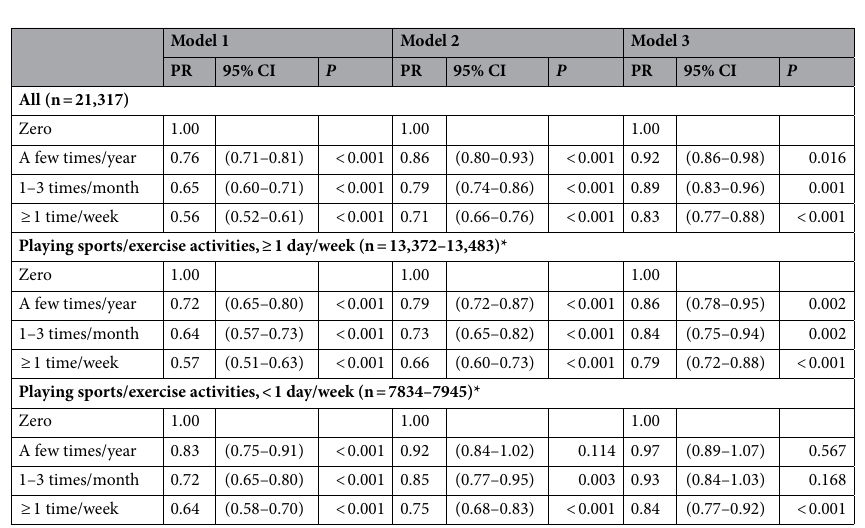
Table 3. Prevalence ratios (PRs) and 95% confidence intervals (CIs) of depressive symptoms according to frequency of watching sports via TV/Internet. * Estimation sample varies across imputations. Depressive symptoms were defined as a 15-item Geriatric Depression Scale score ≥ 5. Model 1, adujusted for sex and age groups. Model 2, model 1 + frequency of playing sports/exercise, marital status, living alone, occupational status, years of education, equivalent income, drinking, smoking, disease status, body mass index, and instrumental activities of daily living. Model 3, model 2 + general trust, norms of reciprocity, attachment to the neighborhood, frequency of meeting friends, and number of friends